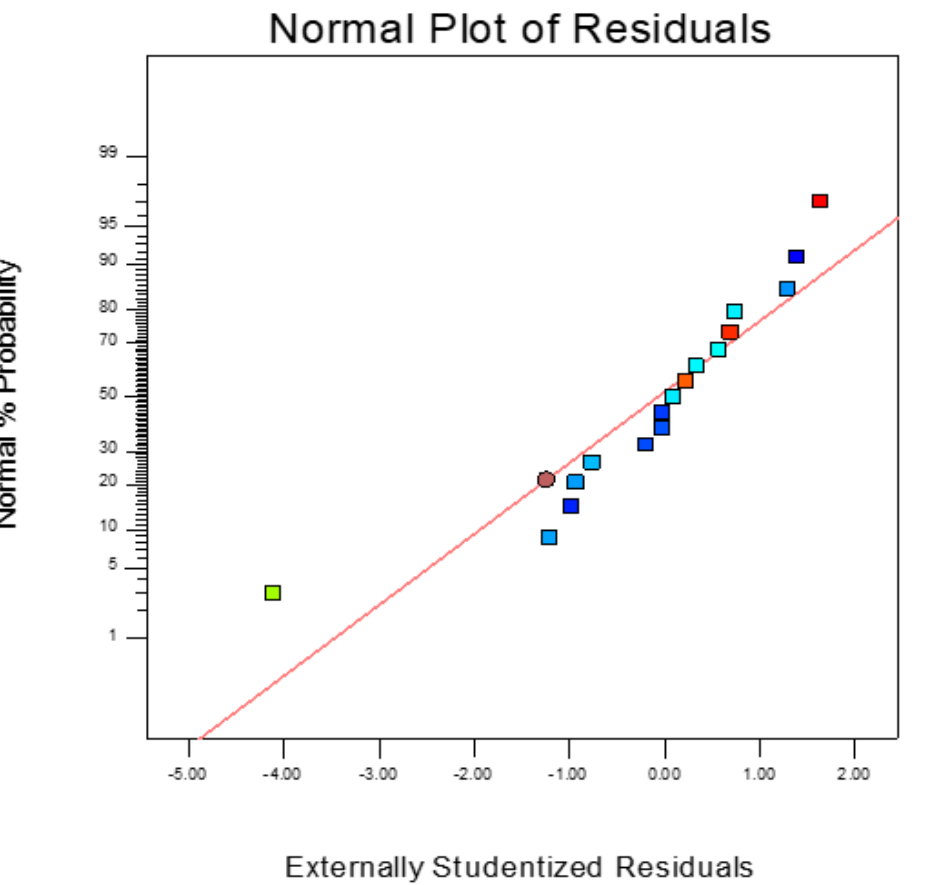
Figure 6. Normal plot of residuals on biogas generation (ml / g VS) for AD of pot ale.